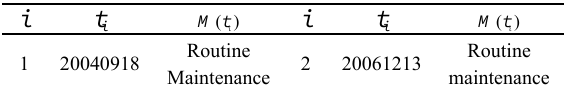
Table 8 Time Series of Maintenance Time at Mileage Point K669+350 in Jing-Hu Up-going